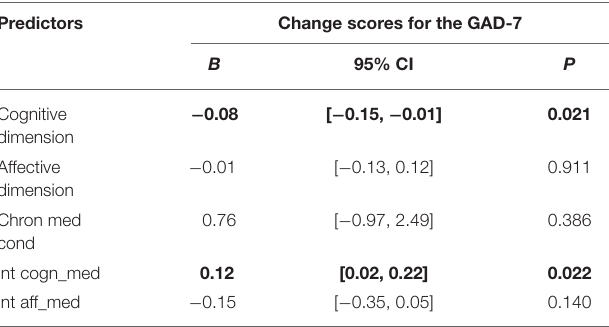
TABLE 3 | Linear regression of raw change scores for the GAD-7 on the BVAQ dimensions and covariates. Predictors Change scores for the GAD-7